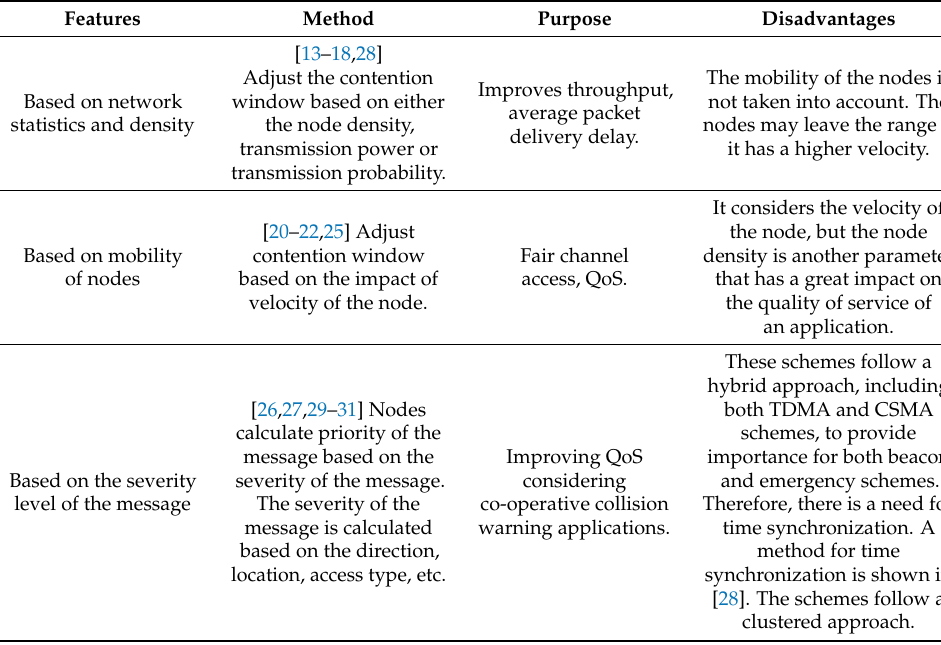
Table 2. Classification of works under safety message